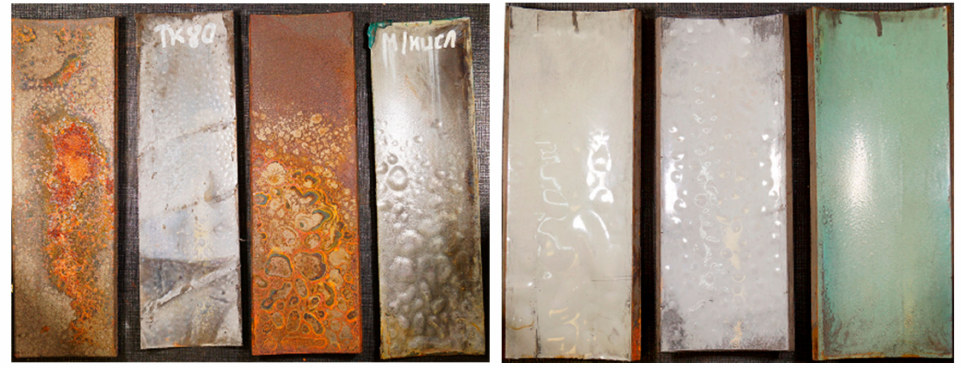
Figure 19. Samples after decompression tests with H 2